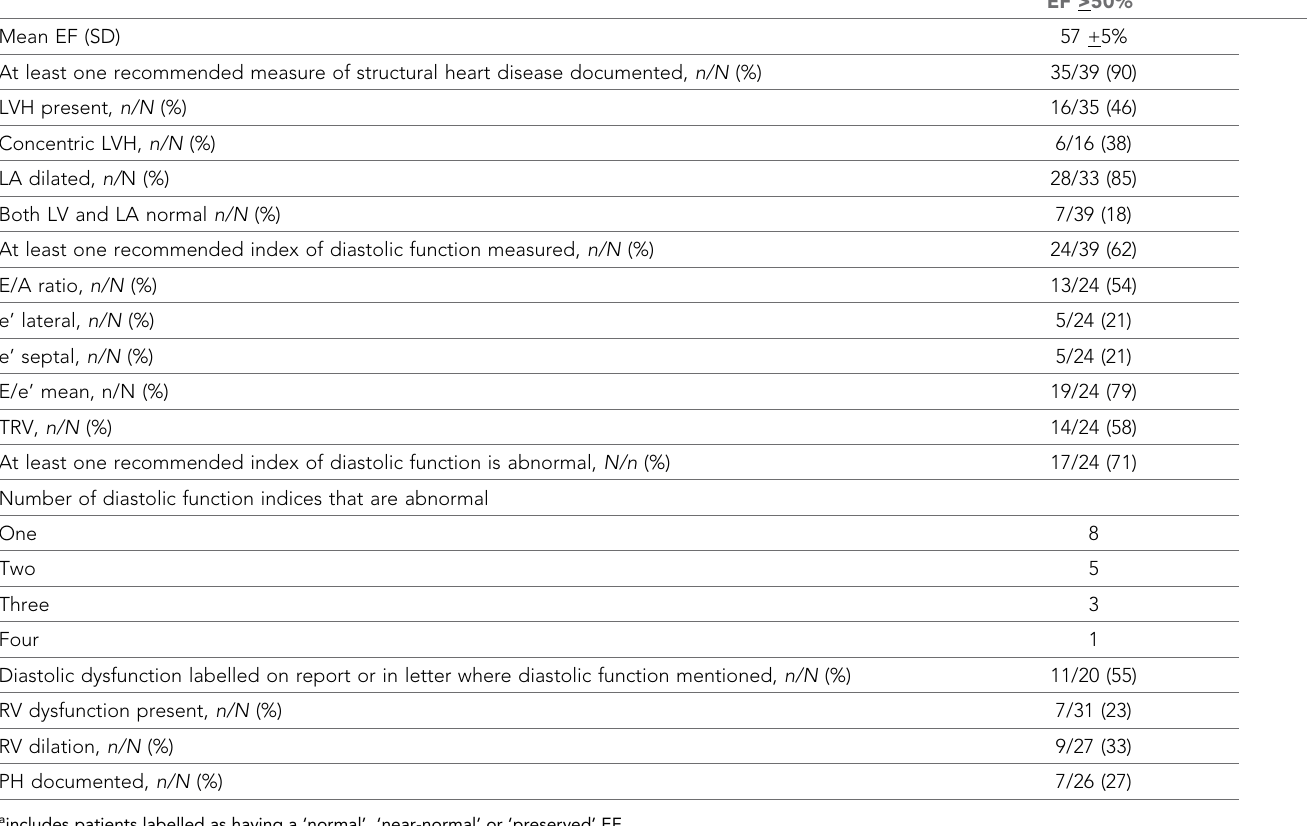
Table 3. Echocardiographic data in 39 patients with EF